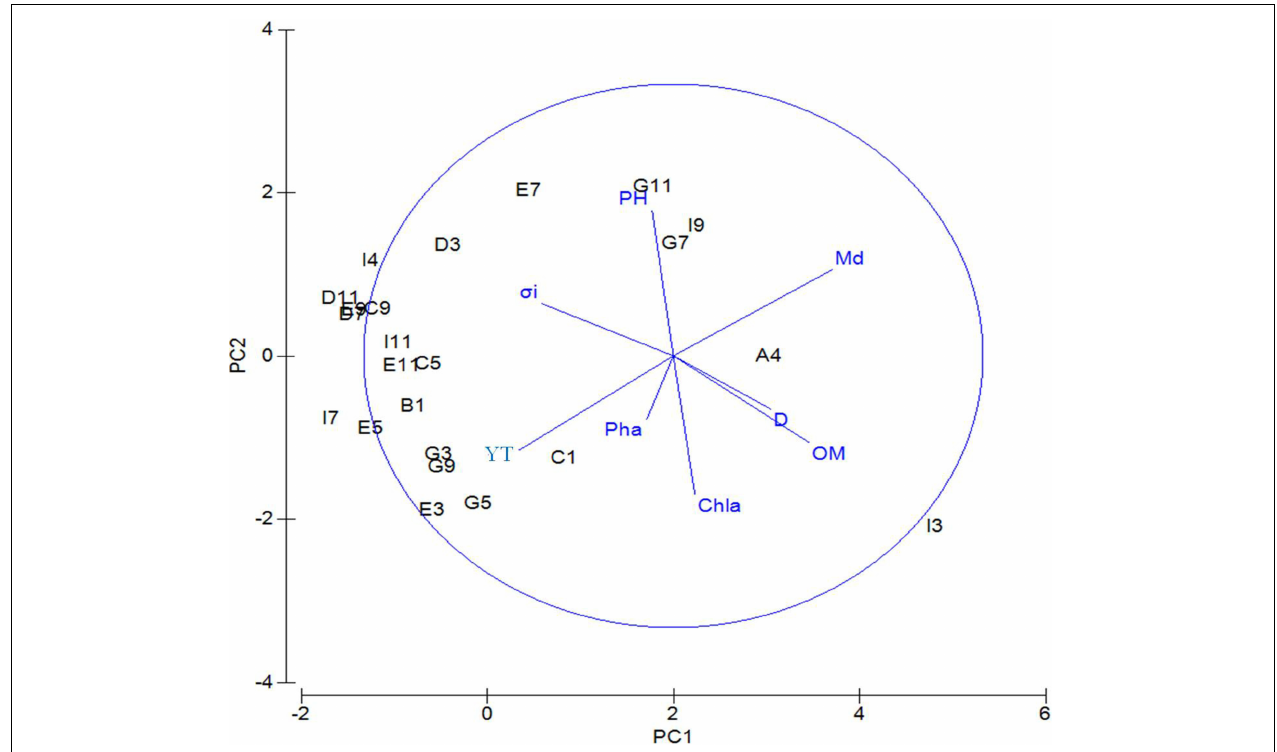
FIGURE 2 | PCA of environmental factors for the sampling sites near the Yap Trench of the Western Pacific Ocean. D , water depth; BWS, bottom water salinity; Md ∅ , median grain size; YT, silt–clay content; Chl-a, chlorophyll a content; Pha, pheophorbide; OM, organic matter content; σ i, sorting coefficient.